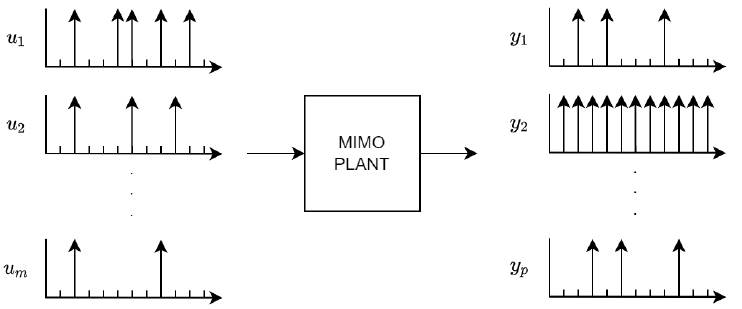
Figure 3. Sampled MIMO